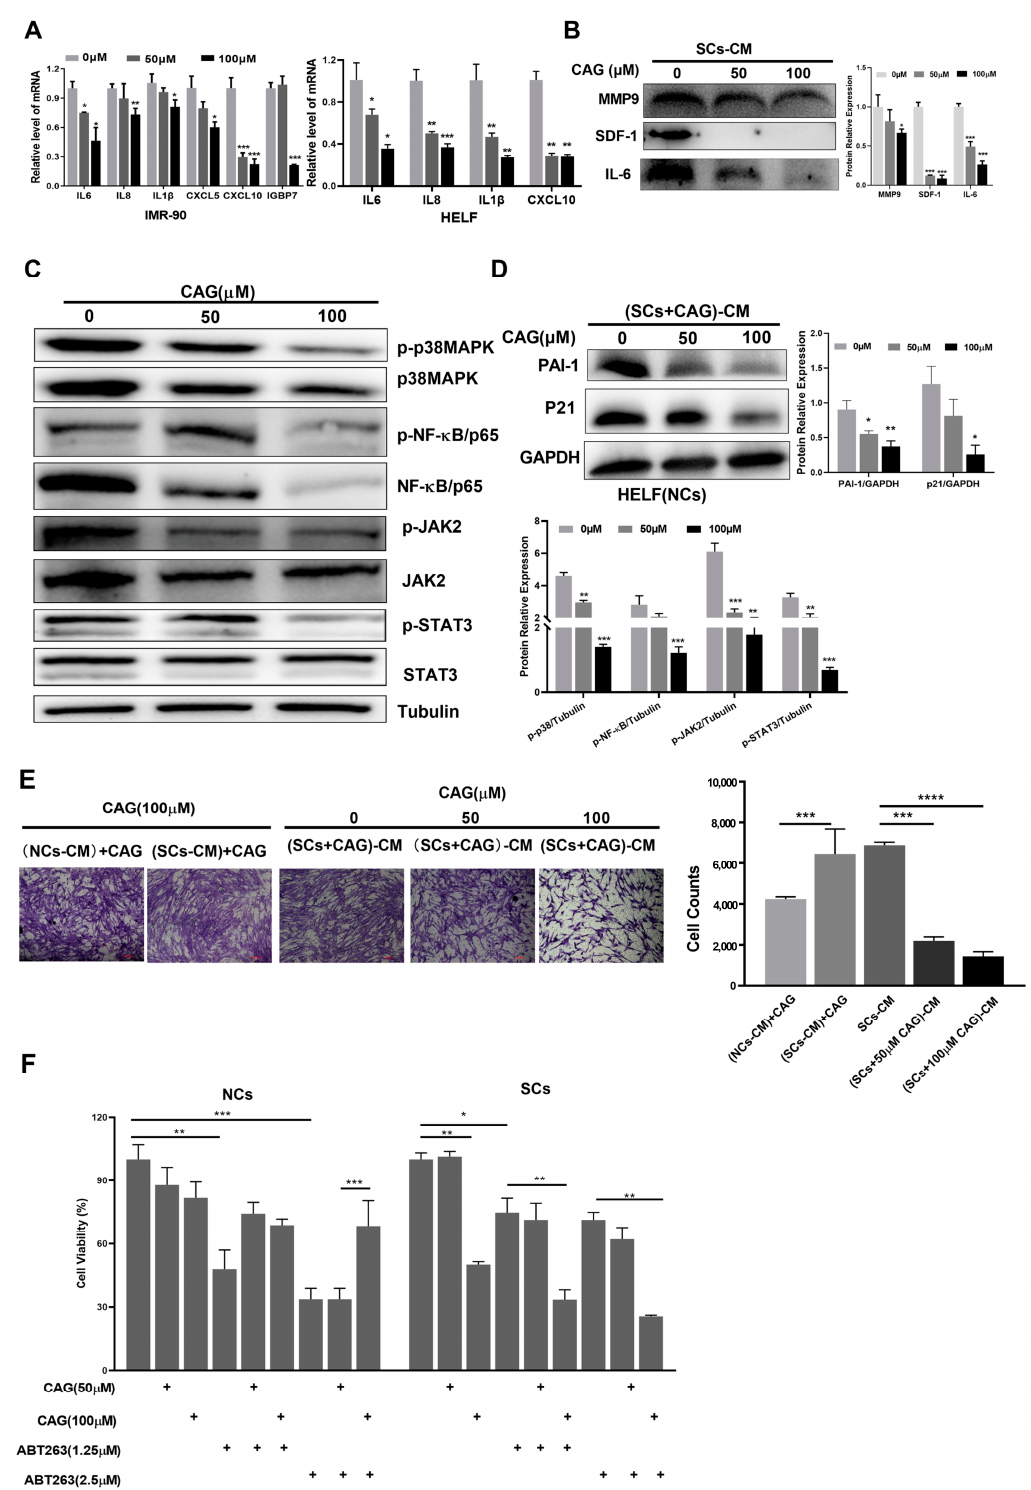
Figure 3. CAG suppresses the SASP and decreases senescence and cell migration induced by SCs. ( A ) The relative mRNA abundance of key SASP components in senescent IMR-90 and HELF cells treated with different concentrations of CAG. RNA was collected and real-time PCR was performed. ( B ) CM was collected from senescent HELF cells (SCs-CM). Cytokine protein levels in CM were measured using Western blots. ( C ) The expression levels of p38, MAPK, NF- κ B, JAK, and STAT3 in SCs after